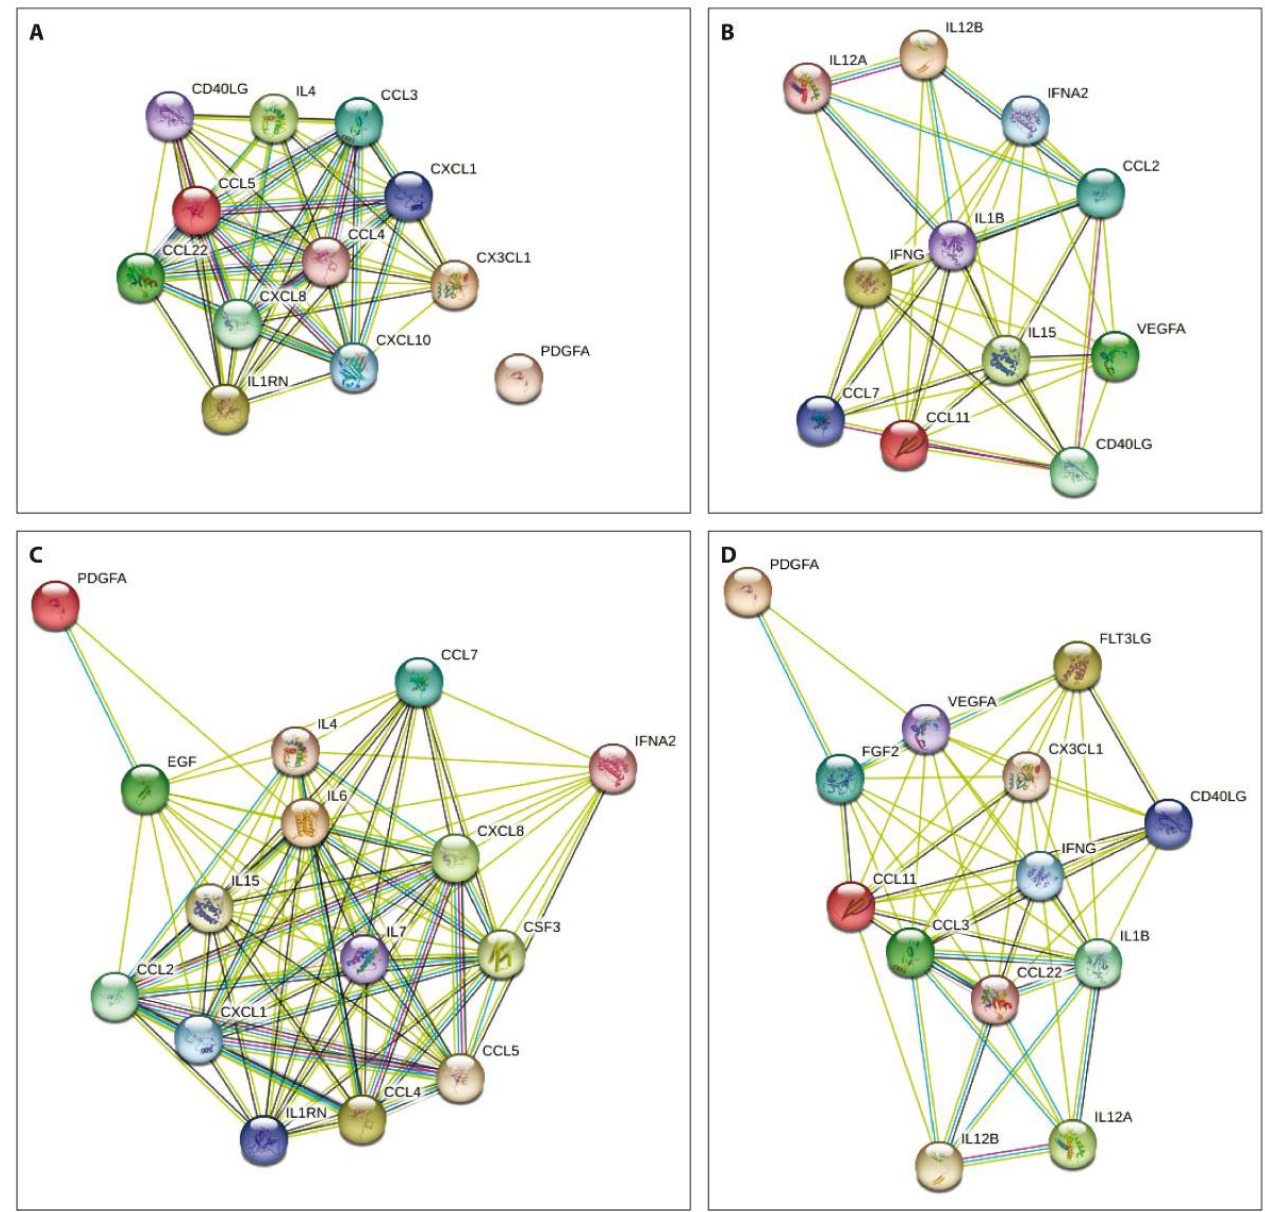
Figure 3. Protein–protein interactions of the examined cytokines prior to ( A , B ) and one week after ( C , D ) PRP ( A , C ) or SVF ( B , D ) injections. Nodes show cytokines and the lines previously identified interactions between indicated proteins.